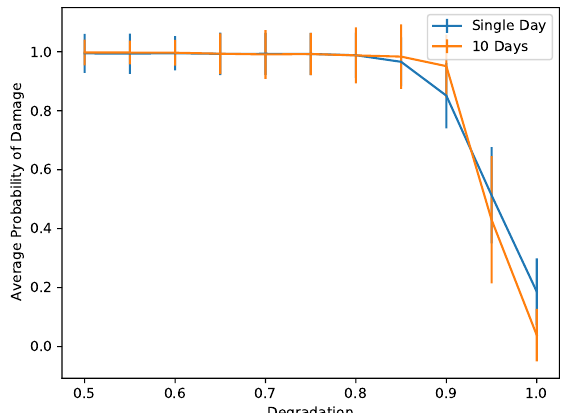
Figure 12. Comparison of the performance between networks using a single and a 10-day long MIM when the training is done with a degradation coefficient of 0.8 while the testing is performed for damages with different degradation levels. Five natural modes are